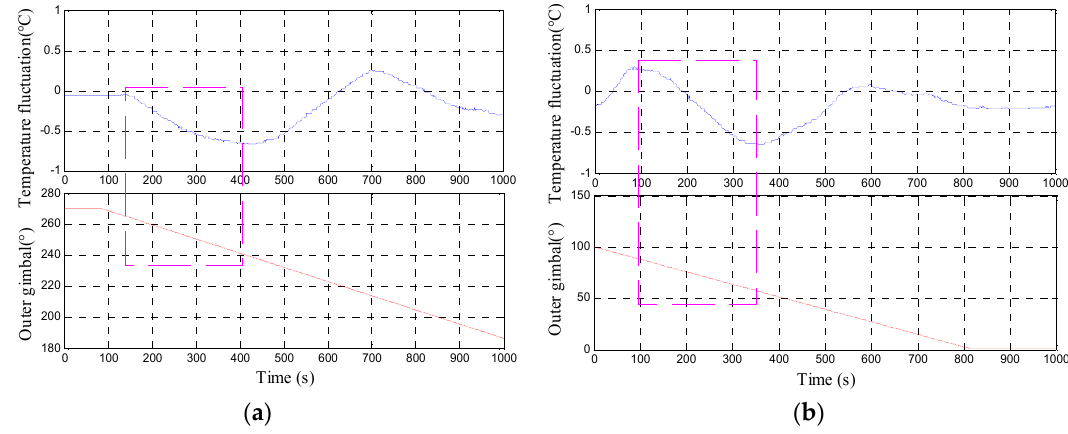
Figure 8. Temperature fluctuation of the temperature control system.